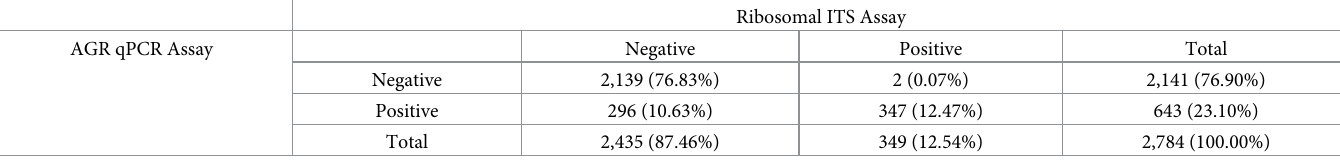
Table 3. Agreement of assay results upon comparative testing of field-collected stool